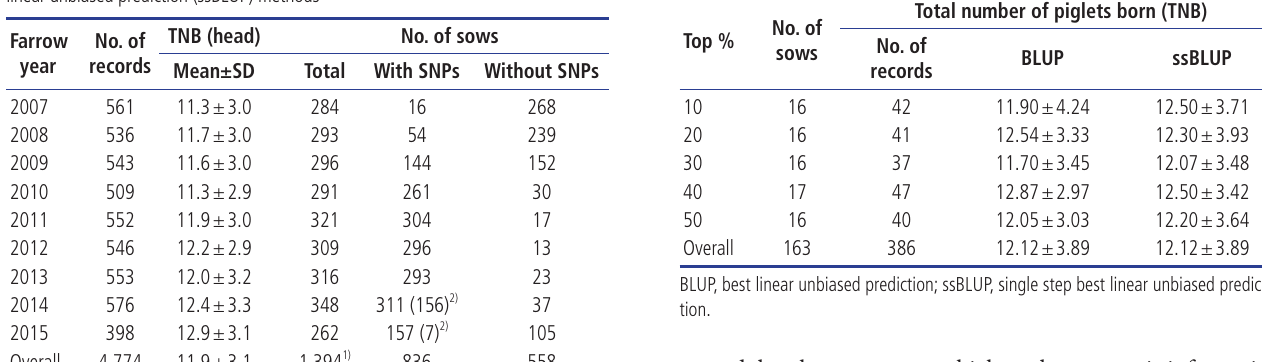
Table 5. Distributional properties of validation data of the phenotypic total number of piglets born (TNB) by best linear unbiased prediction (BLUP) and single step best linear unbiased prediction (ssBLUP) methods